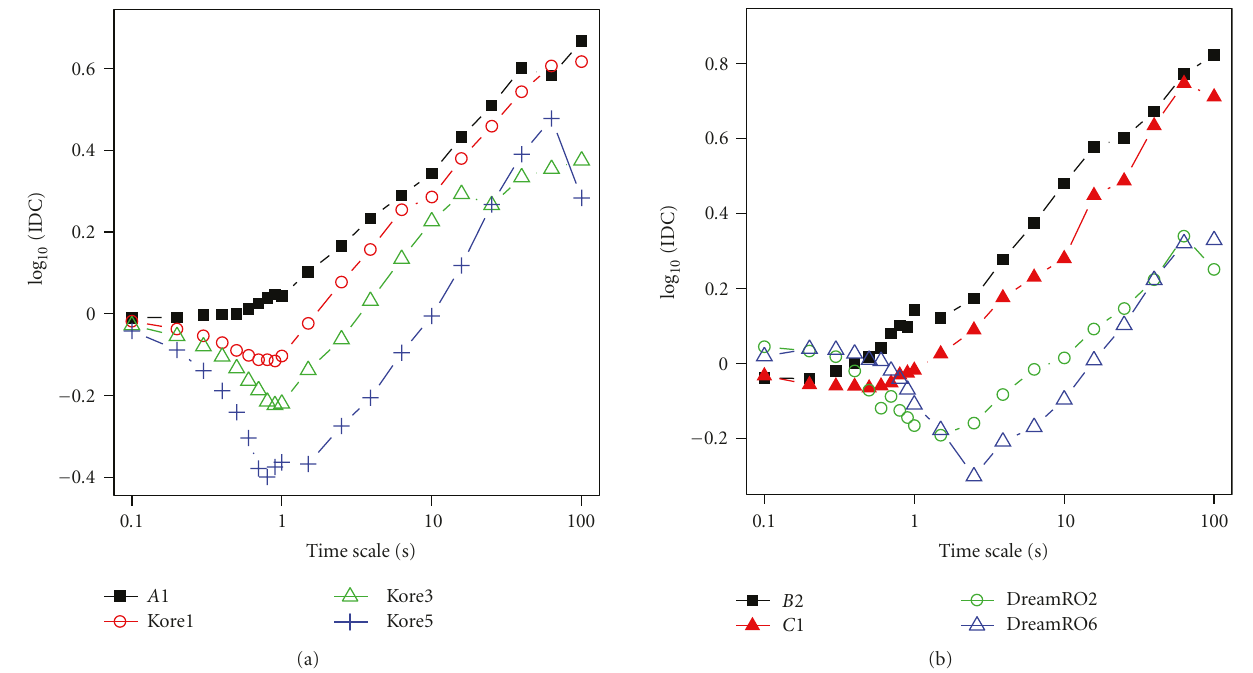
Figure 10: IDC plots for di ff erent traces. Player traces are represented by filled symbols; bot traces are represented by unfilled symbols. Note the trend of IDC for bot traces has a “dip” around 1